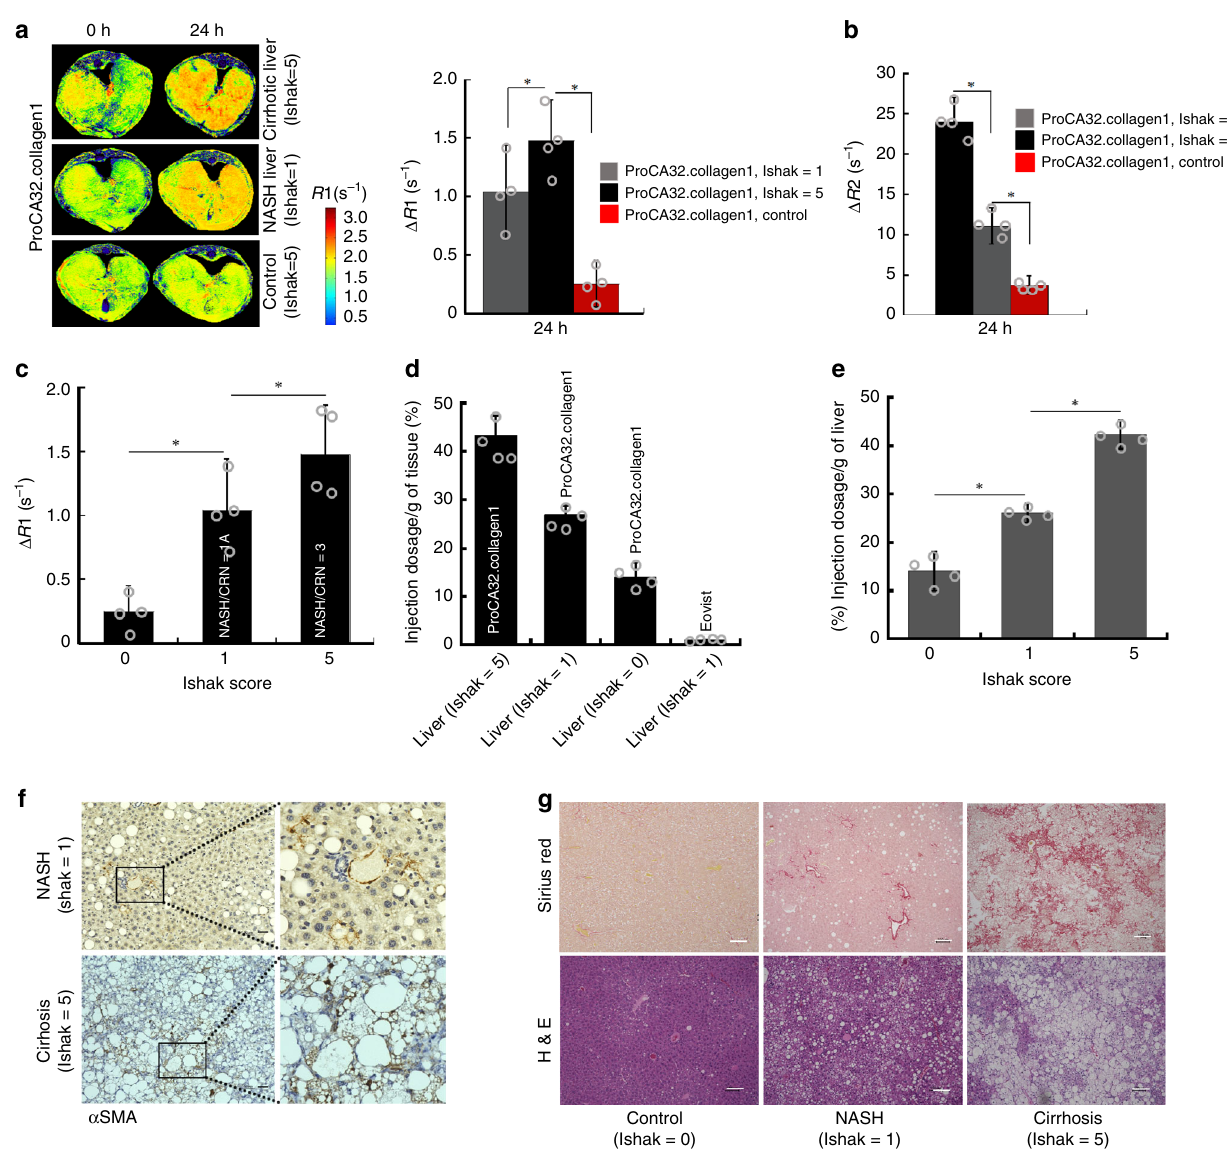
Fig. 3 Early stage detection of NASH in NASH diet model. a R1 maps of NASH liver (Ishak stage 1 of 6 or Mild-1A in NASH CRN system), late-stage liver fi brosis (Ishak stage 5 of 6 or 3 in NASH CRN system), and normal liver (Ishak stage 0 of 6) before and 24 h after injection of ProCA32.collagen1. b Δ R2 values derived from T2 map are consistent with Δ R1 values showing the highest enhancement for late-stage liver fi brosis. c ProCA32.collagen1 can distinguish early-stage NASH from normal and late-stage fi brotic liver with Δ R1 at 24 h time point. d Correlation between Gd 3 + concentration in liver with Ishak scores at 24 h time point. e Percent injection dosage of ProCA32.collagen1 based on [Gd 3 + ] in NASH, late-stage fi brotic and normal liver at 24 h time point. f α SMA staining of early-stage NASH and late-stage fi brosis demonstrates the degree of steatosis which is much higher in late-stage fi brosis (scale bar, 50 µ m). g Sirius red, and H&E staining of early-stage NASH compared to normal liver demonstrate the presence of steatosis and collagen, as indications of the disease stage. scale bar, 100 µ m; * P < 0.05, unpaired two-tailed student ’ s t test; all data are represented as mean ± SD, n = 4 biologically independent animals in each